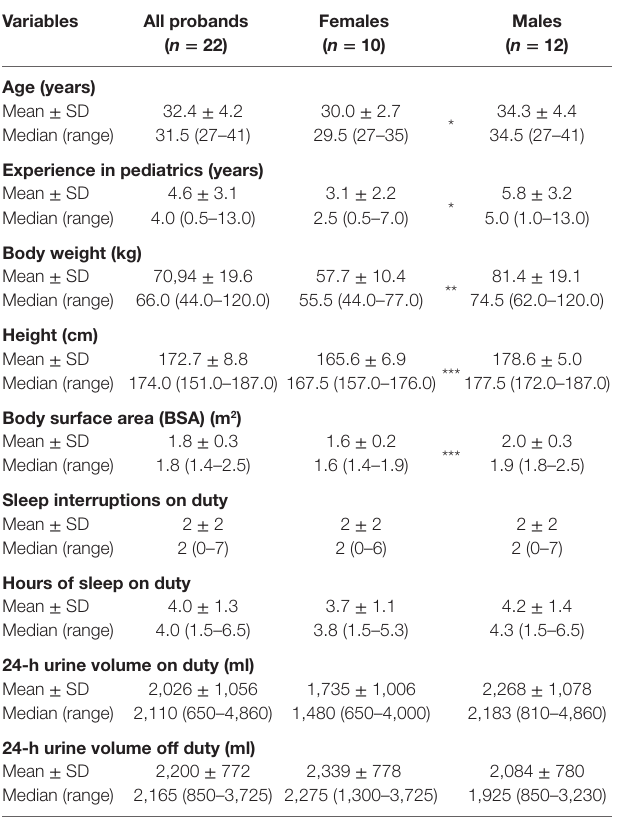
Table 1 | Clinical characteristics of the population.